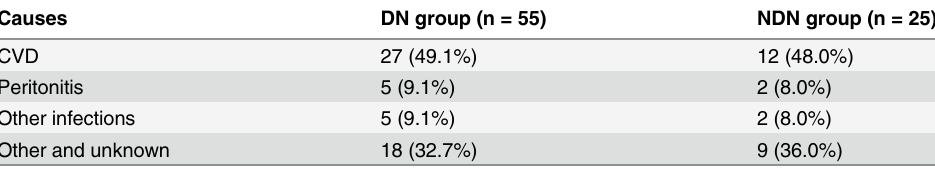
Table 4. Causes of death in DN group and NDN